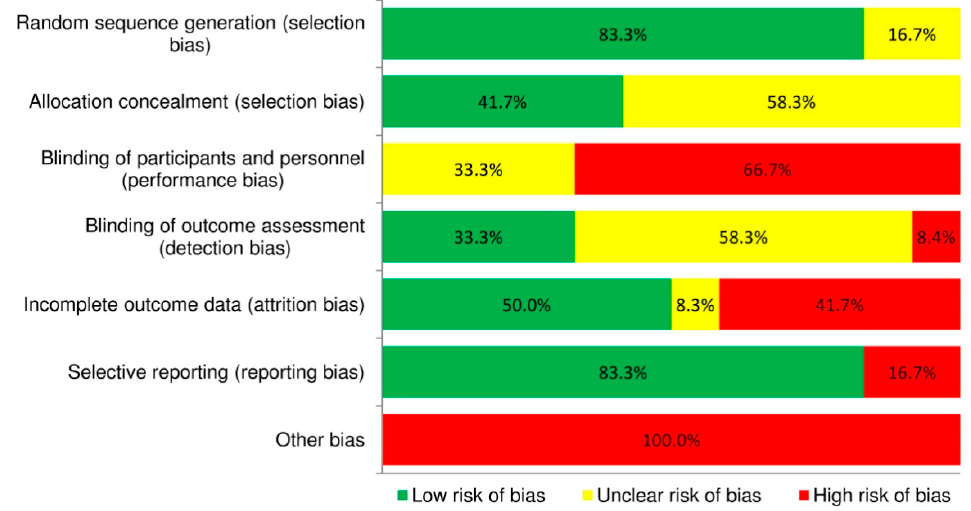
Figure 2. Proportion of included articles assessed as having low, unclear and high risk of bias.